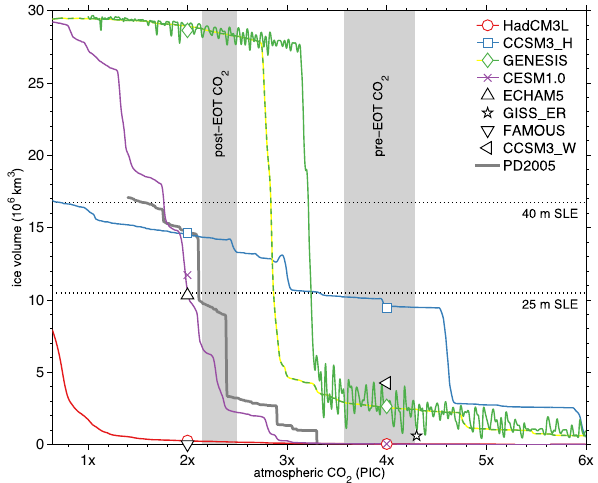
Fig. 4. Transient CO 2 ISM experiments using climate output from HadCM3L, CCSM3_H, CESM1.0 and GENESIS simulations. Cli- mate is calculated by linearly interpolating and extrapolating be- tween the simulations at 4 × PIC and 2 × PIC over 1.5Myr, start- ing with unglaciated conditions at 6 × PIC (simulations run right to left). Offline simulations are shown as solid markers, with additional simulations from FAMOUS, ECHAM5, GISS_ER and CCSM3_W. The climate for the transient experiments is calculated by interpo- lating and extrapolating from the 2 × and 4 × PIC GCM simulations. For GENESIS, simulations are shown with (solid green) and with- out (green and yellow line) astronomical forcing. Horizontal dotted lines are the thresholds for an intermediate (defined here as 25m Eocene SLE) and a large ice sheet (40m Eocene SLE). Also shown is the simulation of Pollard and DeConto (2005) for a reduction in atmospheric CO 2 and without astronomical forcing. The vertical bars are the pre- and post-EOT atmospheric CO 2 proxy estimates of Pagani et al. (2011)